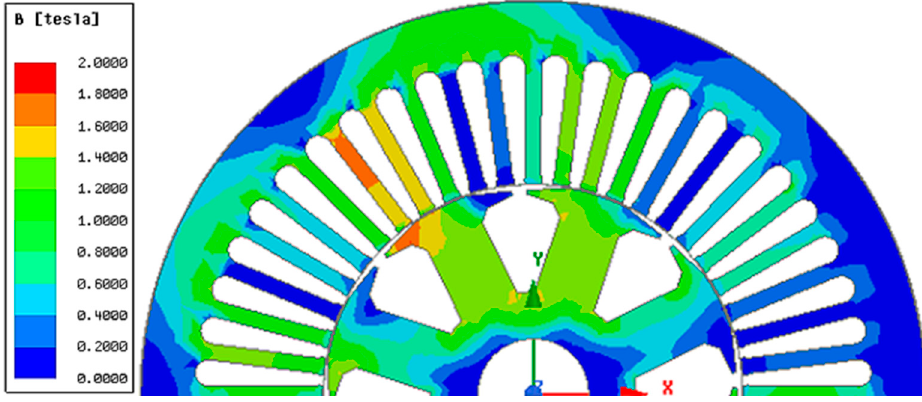
Figure 11. Flux density distribution (optimal model).